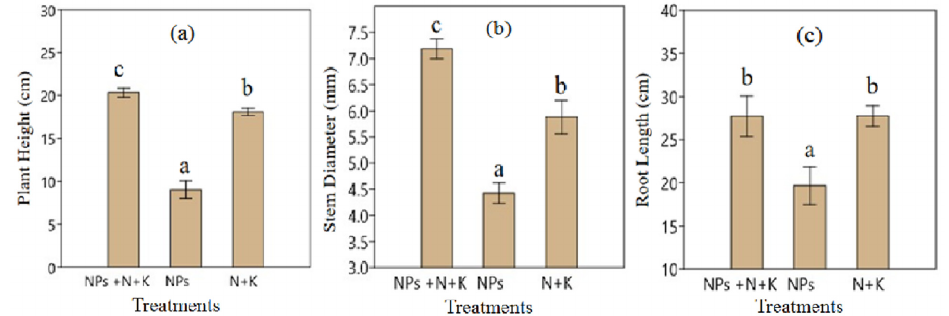
Figure 3. The ration effects of biochar nanoparticles, nitrogen, and potassium on Chinese cabbage of height ( a ), stem diameter ( b ) and root length ( c ) after four weeks treatments. (Note, NPs+N+K: BNPs-N-K=1:2:2 (T1), NPs: BNPs-N-K=2:0:0 (T5), N+K: BNPs-N-K=0:2:2 (T6); BNPs, biochar nanoparticles; 1 unit means 0.5 g/L nutrient; Error bars indicate standard error of the mean; Different letters indicate the significant differences with p <